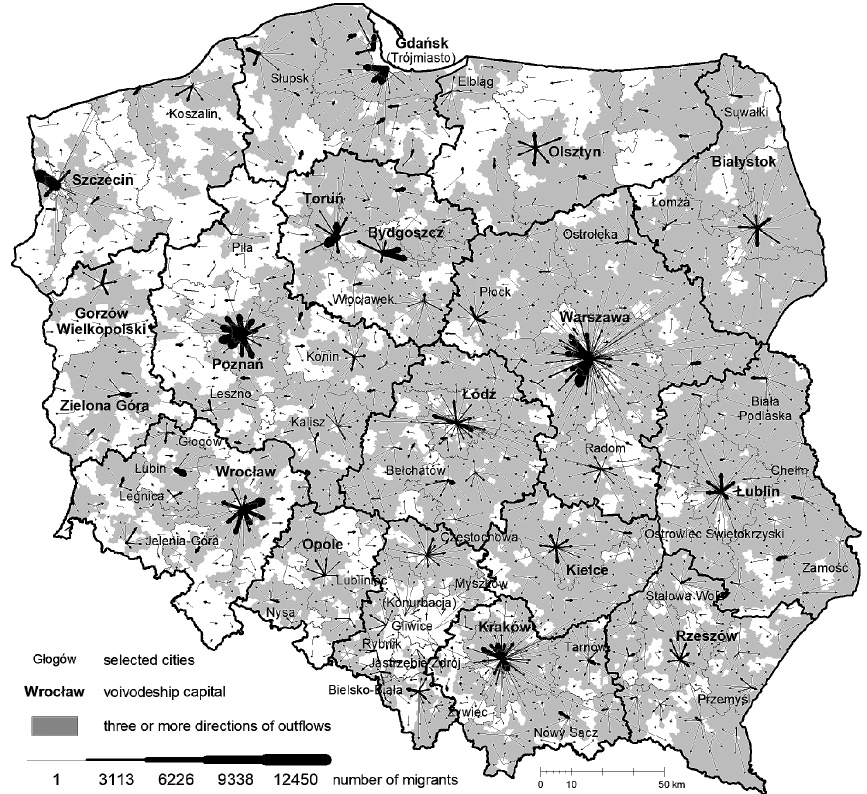
Fig. 2. Areas of migratory attractiveness – rural areas as outmigration destinations (linear scaling). Source: elaborated on the basis of Statistics Poland – Demography database Table 2g (http://demografia.stat.gov.pl/